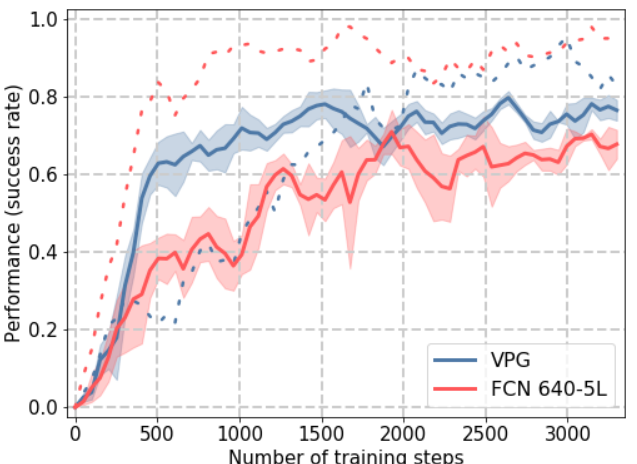
Figure 7. Comparison in training performance between the baseline architecture VPG (based on the DenseNet-121 architecture) and the proposed single-FCN with an input resolution of 640 × 640 px in the simulation environment. The solid line represents the grasping performance (success rate over the previous 200 iterations), while the dashed line represents the push